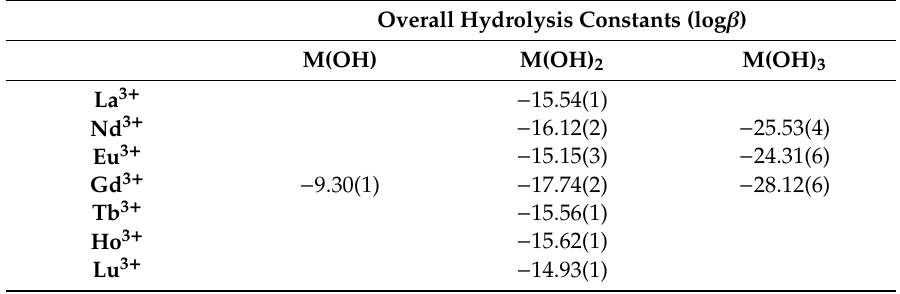
Table 6. Hydrolysis constants of lanthanide(III) ions (standard deviations are given in parenthesis). Overall Hydrolysis Constants (log β